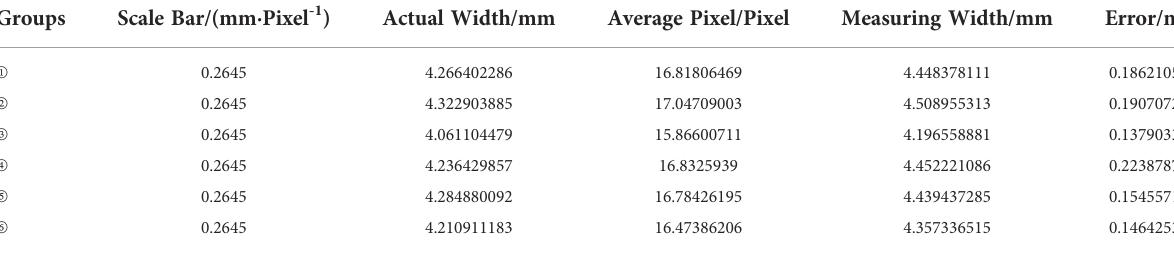
TABLE 9 Comparison of measurement results of leaf vein width. Groups